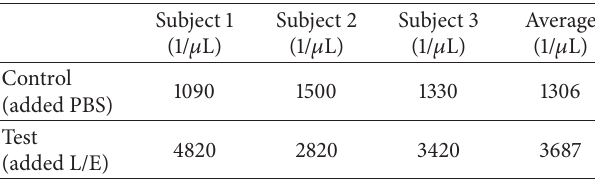
Table 2: Number of events within the chosen flow cytometer SSC- A/FSC-A region corresponding to platelets and EVs (Figure 1) in the isolate from platelet-rich plasma treated with